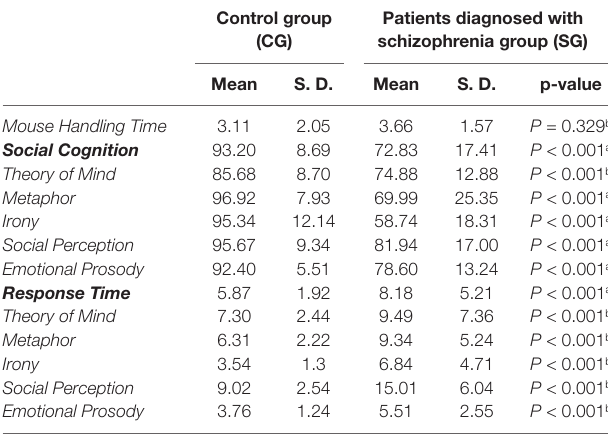
TABle 3 | Differences in social cognition task performance (%) and response time (sec) between CG and